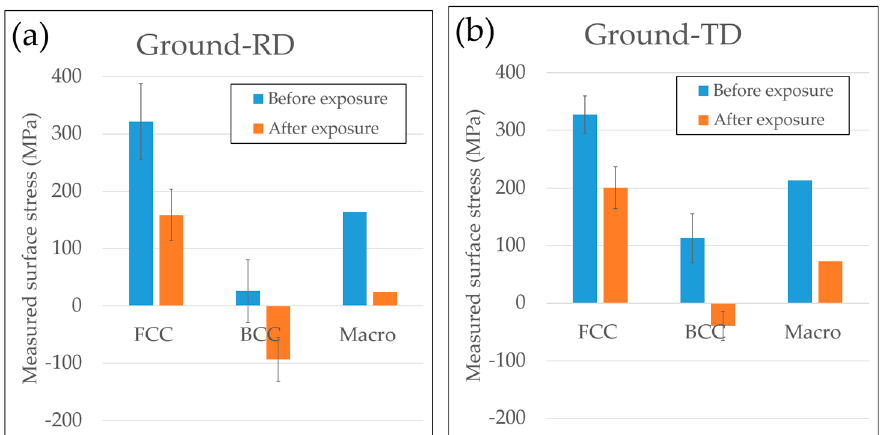
Figure 8. Surface stresses of ground specimens parallel to grinding direction before and after exposure without external loading: ( a ) Ground-RD specimen; and ( b ) Ground-TD specimen